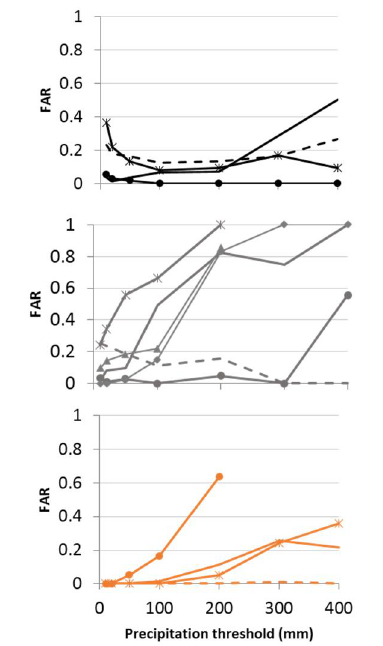
Figure 6. FAR for precipitation thresholds of 10, 20, 50, 100, 200, 300 and 400 mm on the Coastal plains (black), Andean highlands (grey) and Amazonian rainforest (orange)